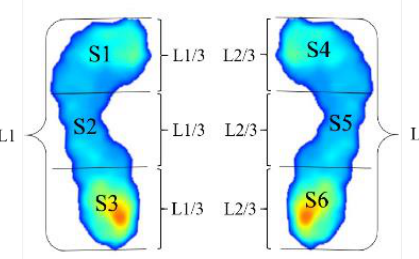
Figure 2. The corresponding area definition of the arch index measurement.